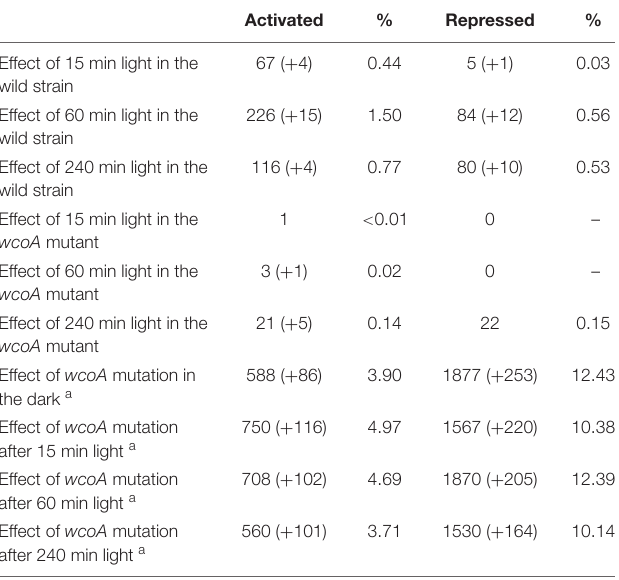
TABLE 1 | Number of genes whose expression changes more than four-fold (log2 = 2) above (activated) or below (repressed) the controls, under the indicated